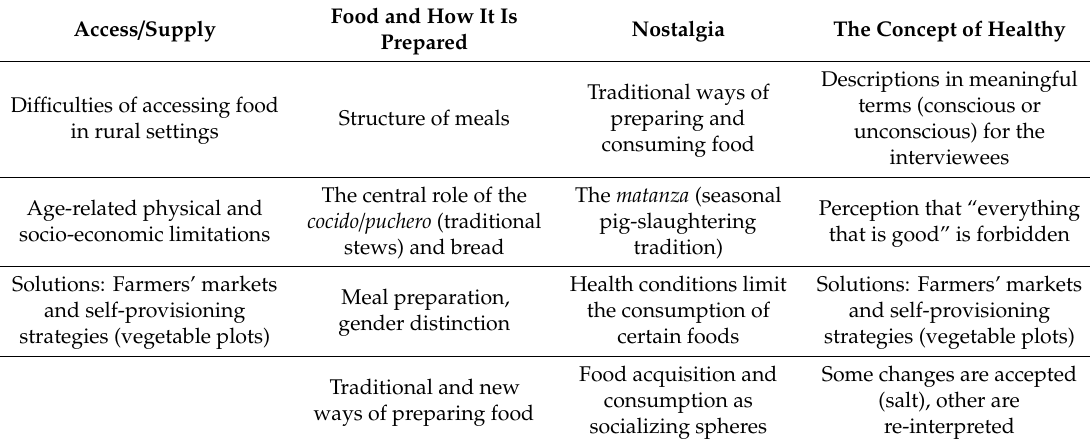
Table 3. Categories of